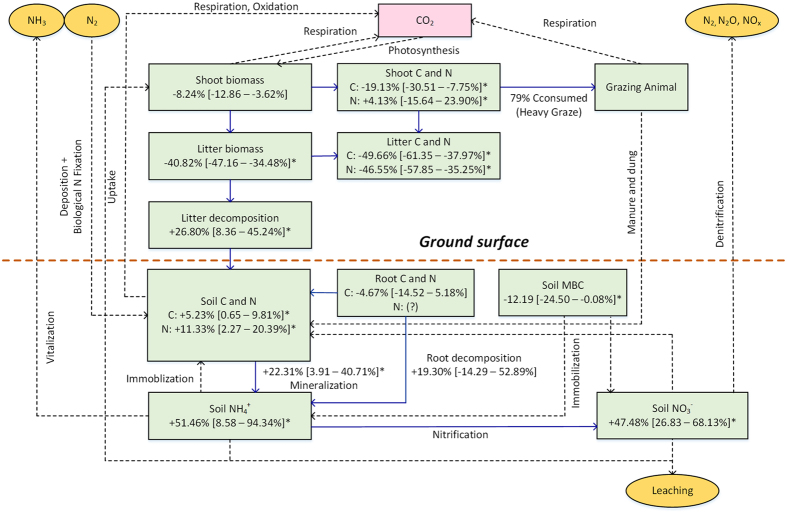
Responses of C and N cycles to grazing in the NGP natural grazing grassland ecosystem.Solid lines represent the carbon and nitrogen processes of corresponding variables synthesized in our meta-analysis. Numbers indicate the mean changes in the C and N cycles with 95% CI. Asterisks indicate statistical significance (P < 0.05). MBC: microbial biomass carbon?, not clear for root N pool response to grazing. Dash lines represent the processes not clear for grazing due to not enough data points summarized.